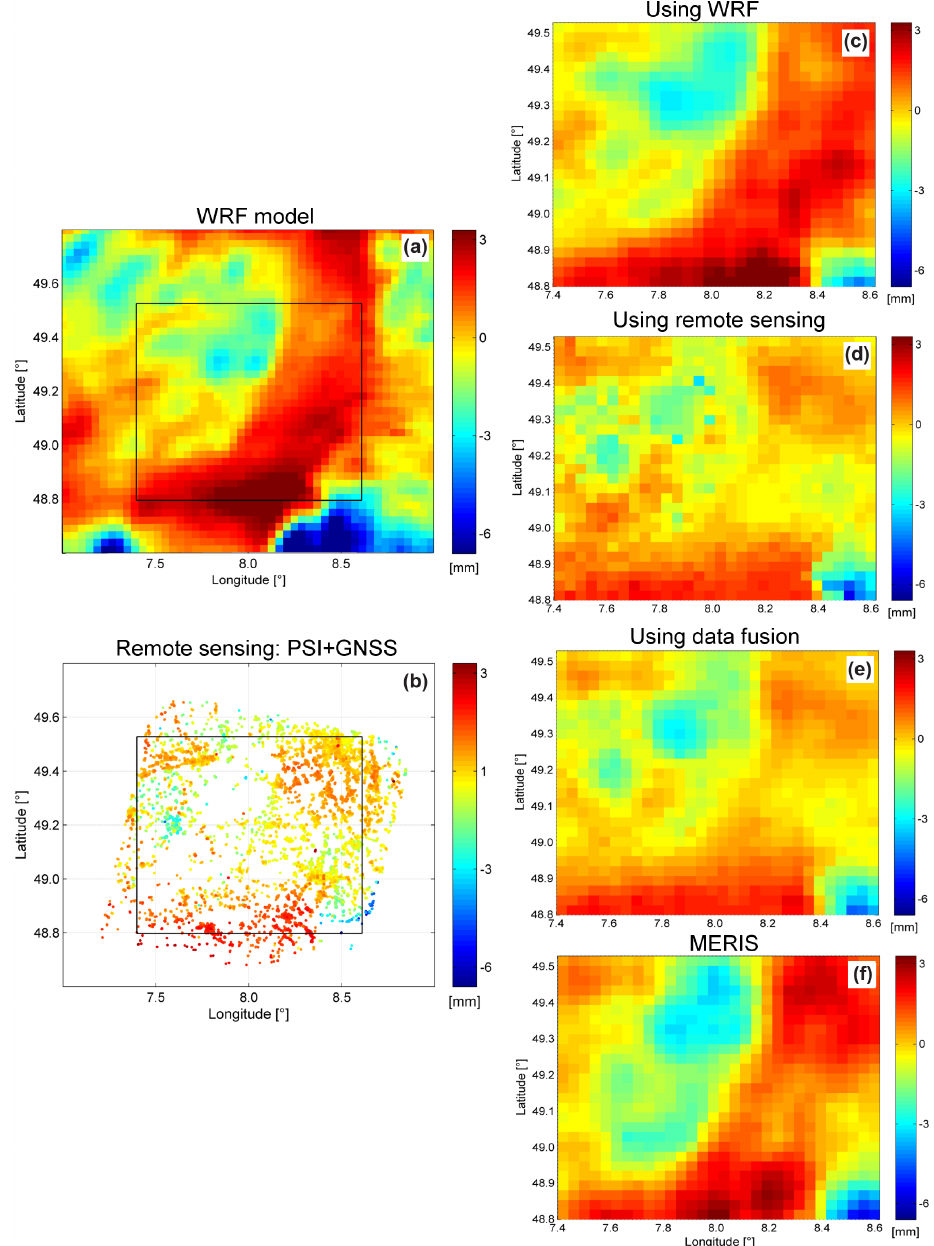
Figure 13. PWV maps from remote sensing (PSI+GNSS) and WRF model data on 27 June 2005 at 09:51UTC as well as prediction maps obtained by data fusion and individual data sets. The output grid has a block size of 3km × 3km over the area indicated by the black box in (a) and (b)